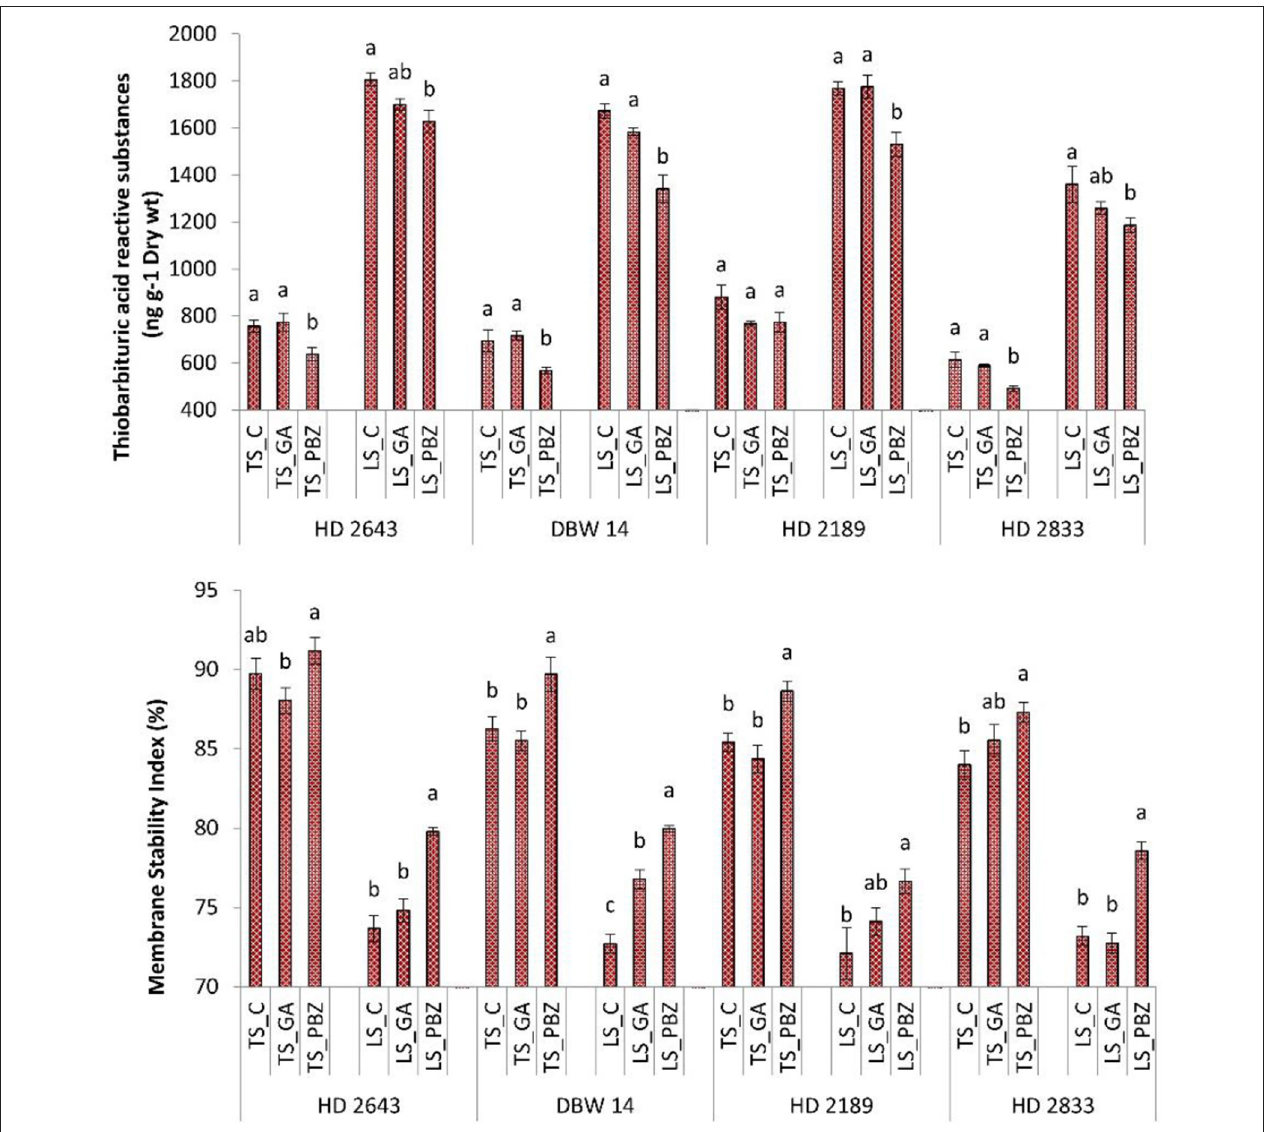
FIGURE 2 | Effect of post-anthesis application of gibberellic acid (100 ppm) and paclobutrazol (50 ppm) on lipid peroxidation (TBARS content ng − 1 dry wt); membrane stability index (%) in wheat exposed to timely and late sown conditions. The different letters on bar denotes significant difference among the treatments within the given variety and stress level according to LSD test at P < 0.05. The error bar represents the standard error. Value on the ordinate is the mean of five replicates. On the abscissa, HD 2643, DBW 14, HD2189, and HD2833 are varieties; TS and LS denote timely sown and late sown of stress treatment, respectively; C, GA, and PBZ denote control, GA3, and paclobutrazol of spray treatment,